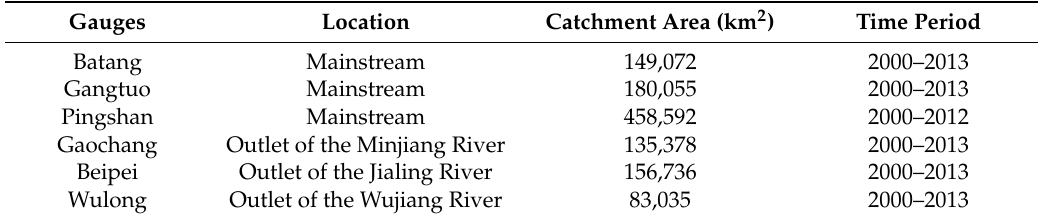
Table 1. Description of the gauging stations and time span of available